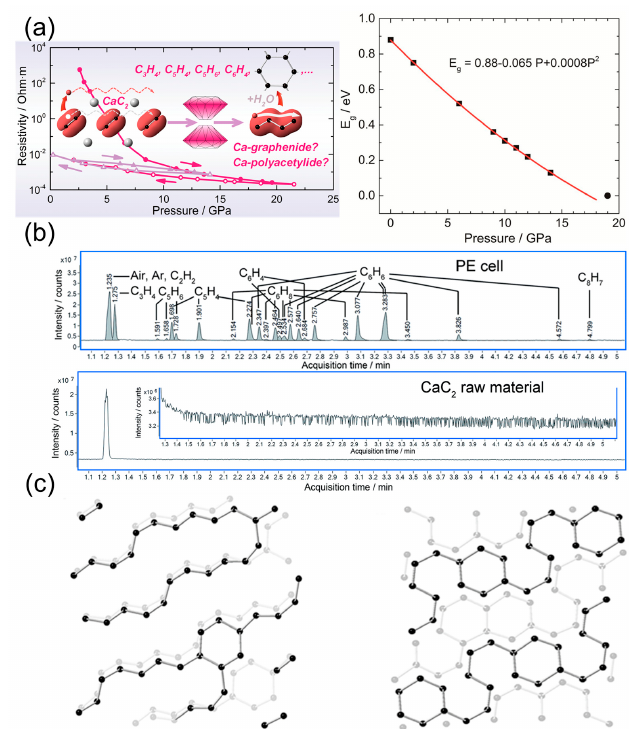
Figure 3. ( a ) The pressure dependent electrical resistivity and band gap of CaC 2 [63]. ( b ) Total ion chromatograms of the product of CaC 2 recovered from 26 GPa and raw material reacting with water [63]. ( c ) Simulated structure of CaC 2 at 30 GPa by meta-dynamics [63].